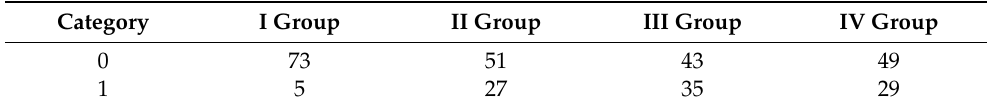
Table 11. Number of observations by category of the dependent variable and group based on quartiles of revenue volumes in 2019.